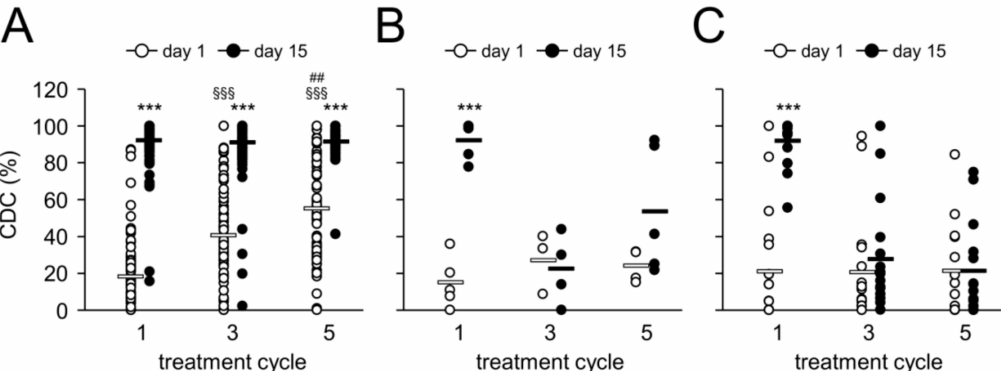
Figure 5. Ch14.18/CHO-mediated CDC and impact of HACA response. Induction of GD 2 -specific ch14.18/CHO-mediated CDC in HACA-negative ( A ) and HACA-positive pts who developed non-neutralizing ( B ) and neutralizing anti-ch14.18/CHO Ab ( C ) was analyzed. CDC was tested in cycles 1, 3 and 5 on d8 after the start of Ab infusion (i.e., d15; closed circles) and compared to the baseline CDC of the respective cycle (d1; open circles) using the cytotoxicity assay as described in “Materials and Methods”. The circles represent pts evaluable for the analysis. Experiments were performed in six replicates. White (non-neutralizing) and black solid horizontal bars (neutralizing) indicate mean values of the respective group. t -test or Mann-Whitney Rank Sum test. *** p < 0.001 vs. d1 of the respective cycle; §§§ p < 0.001 vs. d1, cycle 1; ## p < 0.001 vs. d1, cycle